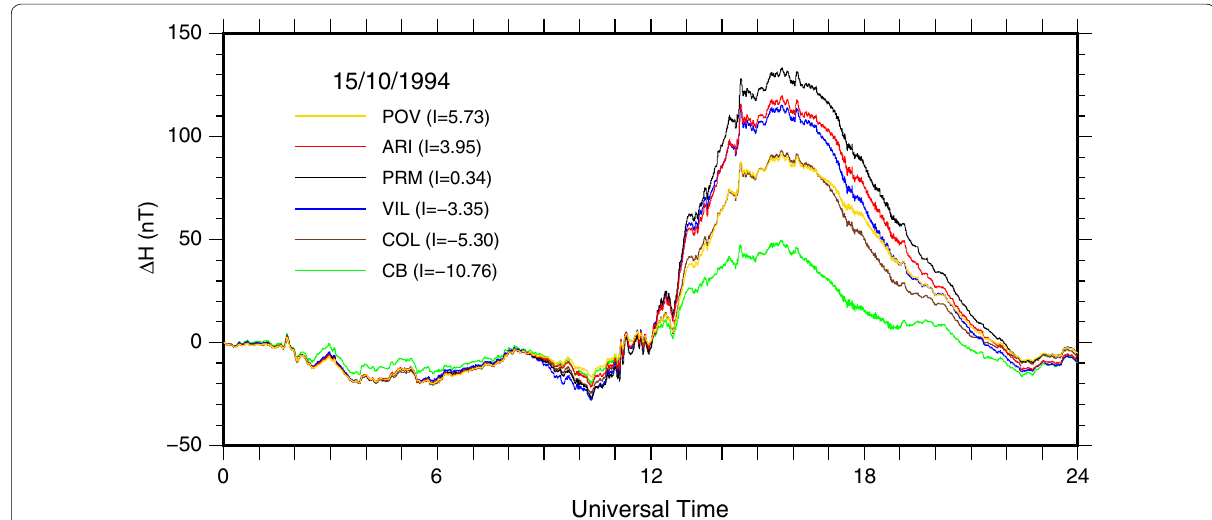
Fig. 2 Variations of the magnetic field H-component at stations near the magnetic equator on October 15, 1994. Magnetic inclination angles are presented for each station which has the following abbreviations and geographic coordinates: Porto Velho (POV; 8.8S, 63.9W), Ariquemes (ARI; 9.56S, 63.04W), Presidente Medici (PRM; 11.2S, 61.8W), Vilhena (VIL; 12.72S, 60.13W), Colibri (COL; 13.7S, 59.8W) and Cuiabá (CB; 15.35S, 56.05W)